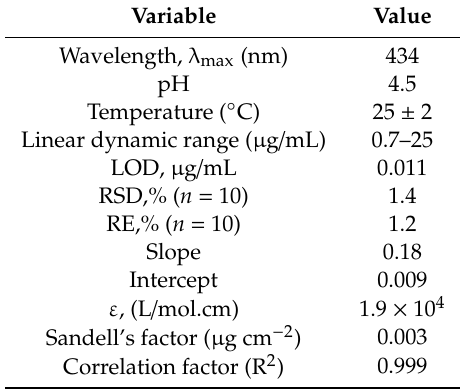
Table 4. Summary of the analytical performance of the spectrophotometric